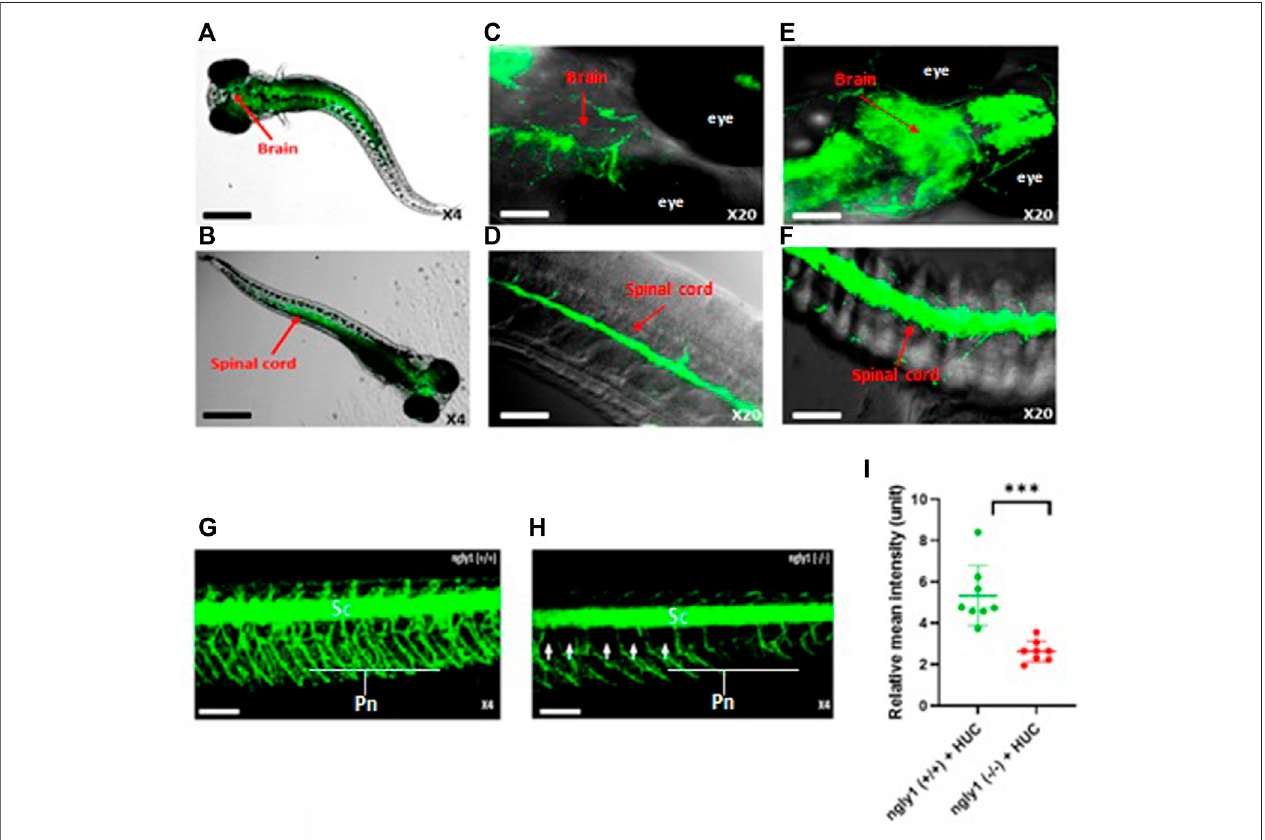
FIGURE 4 | ngly1 ( − / − ) larvae displayed loss of axon fi bers in the PNS compared to ngly1 ( +/+ ) . (A) Dorsal view and (B) ventral view (C) Brain (D) Spinal cord of 6 dpf larvae (WT) identi fi ed by in situ hybridization analysis-X4, X20, confocal Nikon eclipse, n = 10. (E) Brain (F) Spinal cord of Tg (HUC:gal4 uas:mem YFP-mito CFP)- X20, confocal Nikon eclipse, n = 5. (G) ngly1 ( +/+ ) control and (H) ngly1 ( − / − ) mutantgroups at 6 dpf . Sc =spinal cord, Pn = Peripheral nerves, white arrow represents the loss of axon fi bers in PNS. X4, confocal Nikon eclipse. (I) Quanti fi cation of fl uorescence by neurons, t-test ( n = 8 in each group *** p < 0.001). Scale bars: black- 50 µm, white- 20 µm.